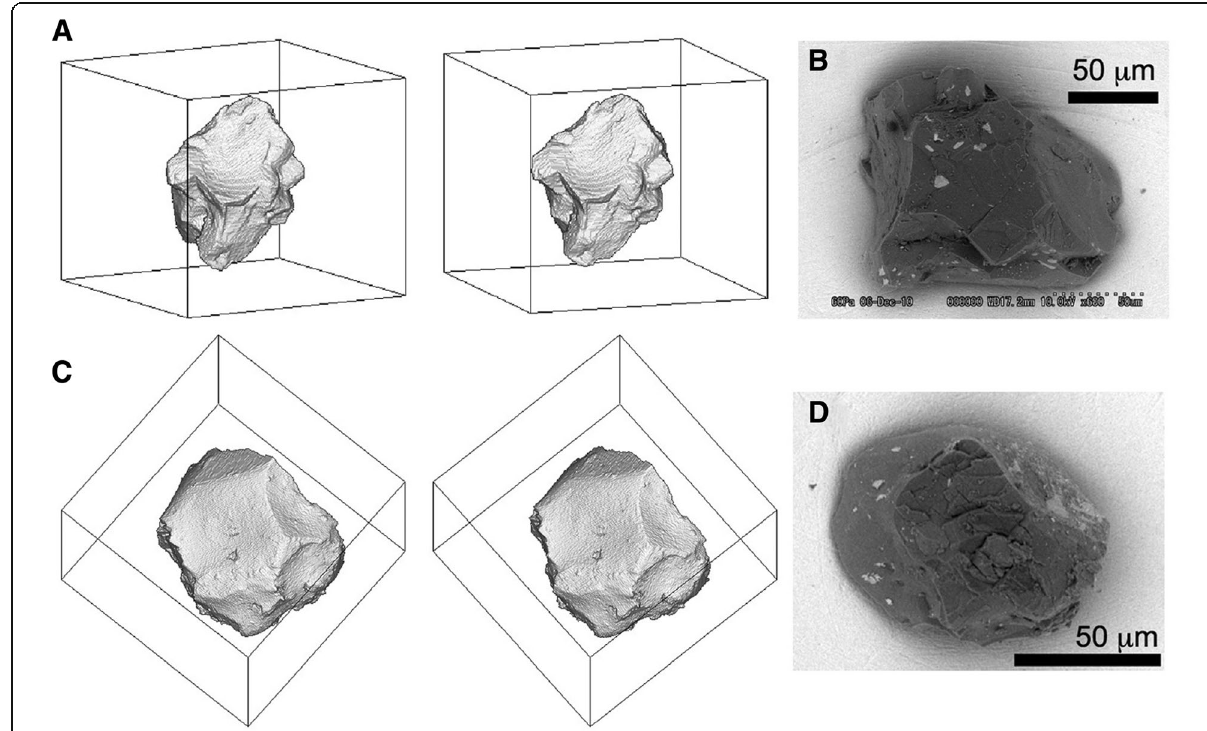
Fig. 12 The 3D external shapes of Itokawa particles. a Stereogram (box size 232 μ m × 232 μ m × 203 μ m) and b SEM micrograph of RA-QD02- 0023. c Stereogram (box size, 112 μ m × 112 μ m × 93 μ m) and d SEM micrograph of